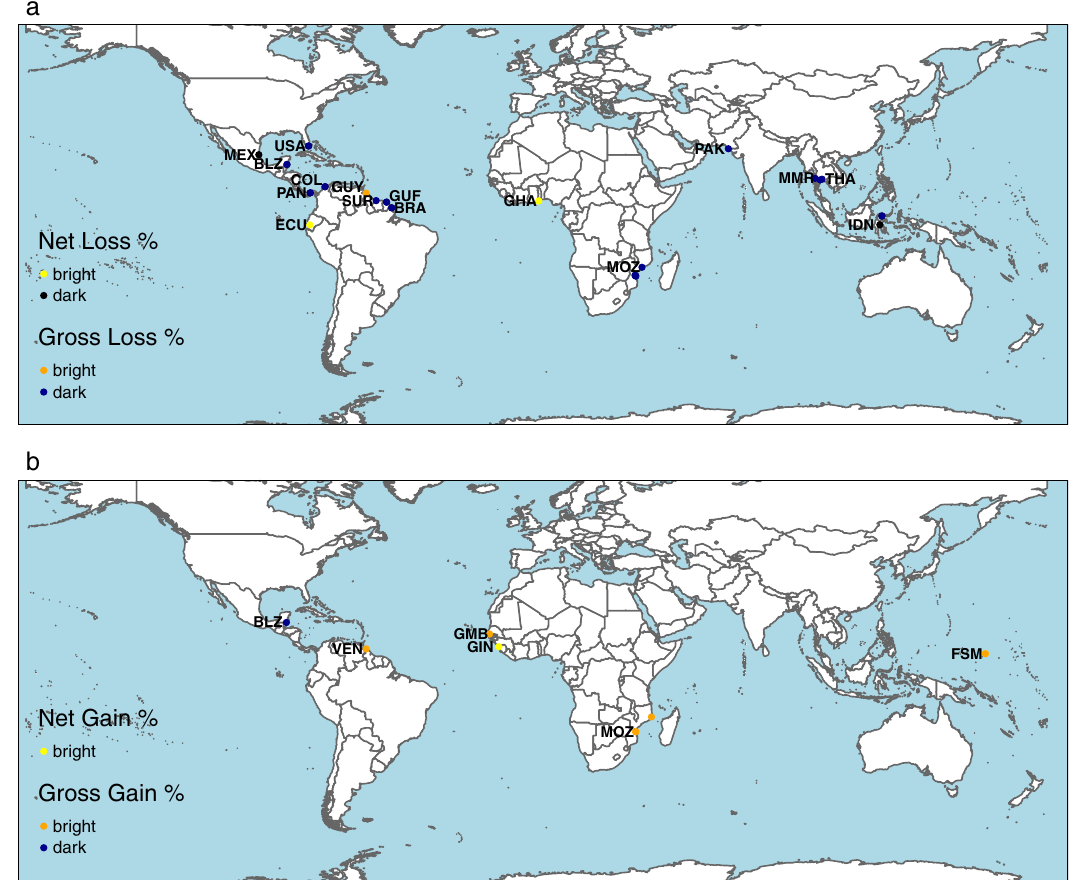
Fig.7|Mangrovelossandgainhotspots. Locationofmangrovegeomorphicunits where percent mangrove net and gross loss in 2007 – 2016 is signi fi cantly (two standard deviations) less (bright) or more (dark) than the country average ( a ; n = 399 and 525 mangrove geomorphic units larger than 50 km 2 across 53 and 58 countriesfornetandgrossloss,respectively);andpercentmangrovenetandgross gain in 2007 – 2016 is signi fi cantly more (bright) or less (dark) than the country average ( b ; n = 126 and 522 mangrove geomorphic units larger than 50 km 2 across 33 and 57 countries for net and gross gain, respectively). There are some over- lappinghotspots;sevennetlossdarkspotsareundergrosslossdarkspots;onenet